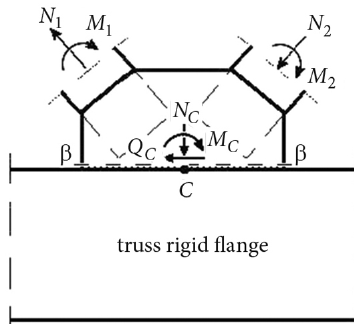
Fig. 10. Method of computation of stresses in gusset plate along β - β